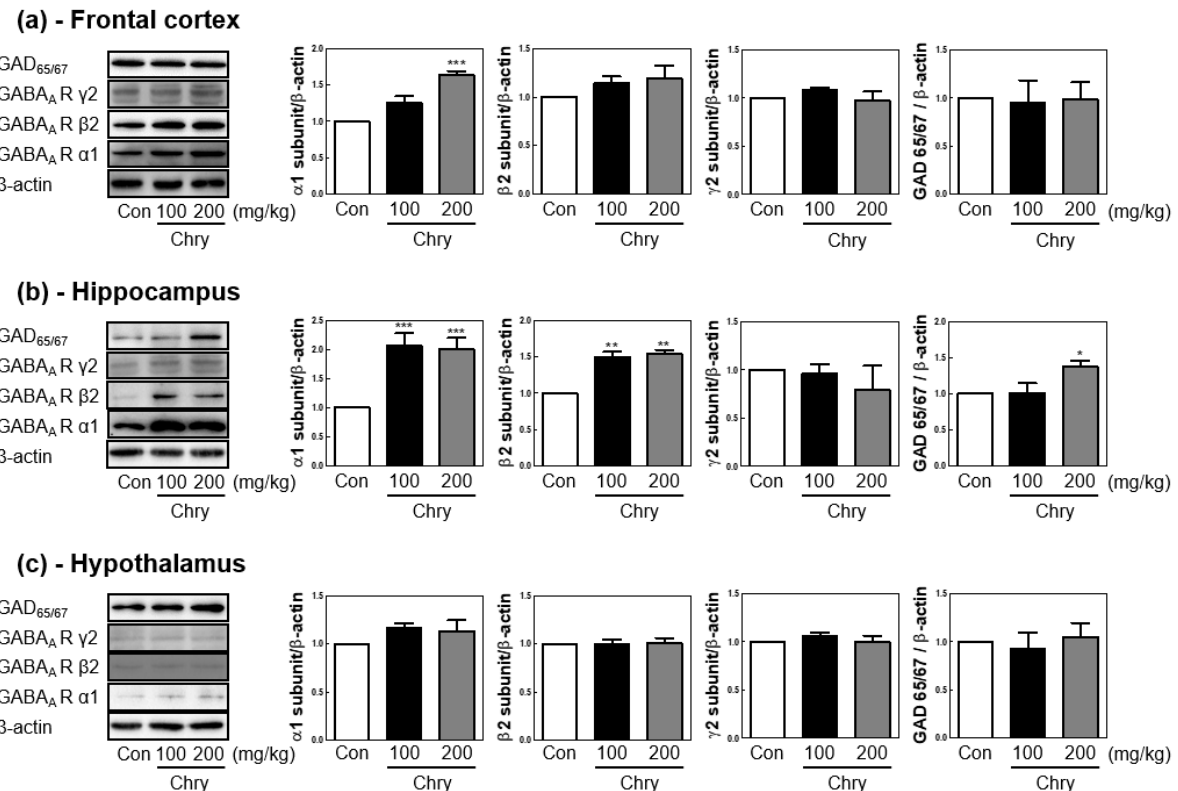
Figure 5. Extract of Chry modulates glutamic acid decarboxylate (GAD) 65/67 and gamma-aminobutyric acid (GABA) A receptor subunits. Western blot analysis of ( a ) rat frontal cortex, ( b ) hippocampus, and ( c ) hypothalamus after EEG analysis. The representative results from three independent experiments are shown, and quantification data are at the right panel. Data are expressed as mean ± SEM. * p < 0.05, ** p < 0.01, and *** p < 0.001, compared with the control group.